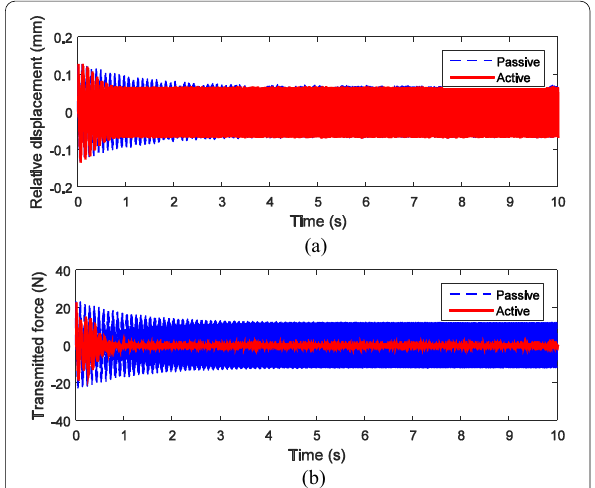
Figure 10 Comparison results of active mount and passive mount at the engine speed of 3000 r/min: a the relative displacement and b the transmitted force